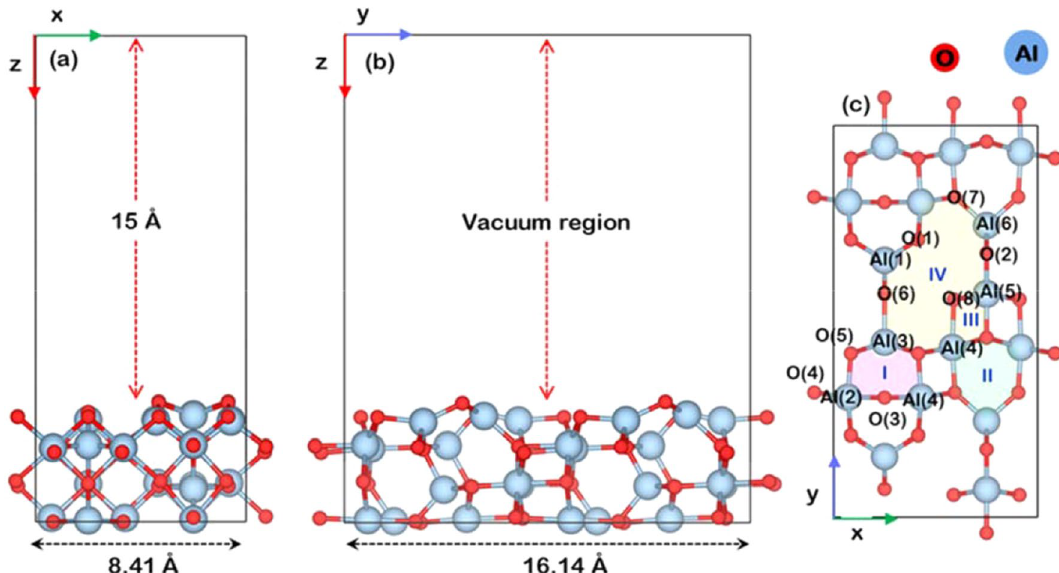
Figure 7. Surface model of γ-Al 2 O 3 (110) projected ( a ) along the (100)-direction, ( b ) along the (010)-direction, and ( c ) along (001)-direction. The vacuum of the slab is set to 15 Å. The zones of the possible active site in ( c ) are classified into the zone I, II and IV as labeled in magenta, green, and yellow, respectively. Note that the atomic radius of each atom is modeled to its isolated atomic